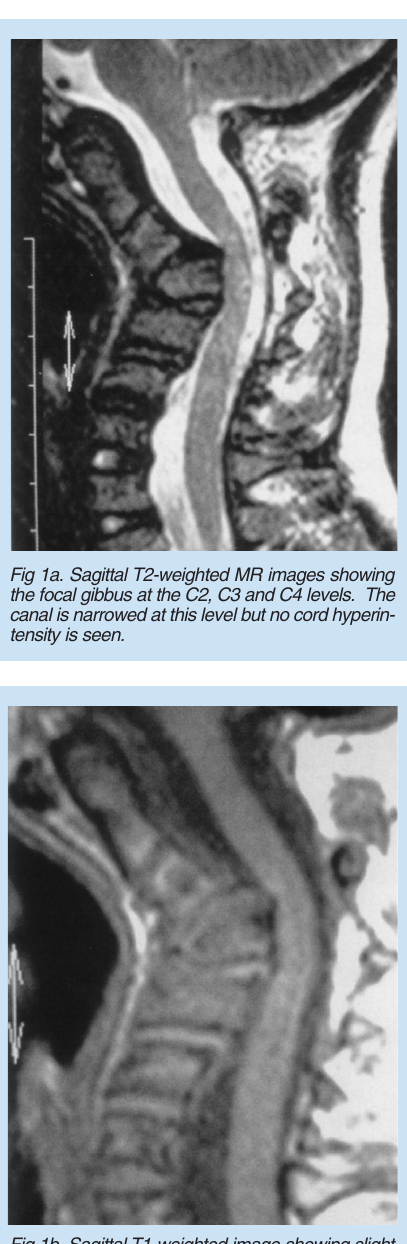
Fig 1b. Sagittal T1-weighted image showing slight posterior vertebral body scalloping and dural ecta- sia at the C5 and C6